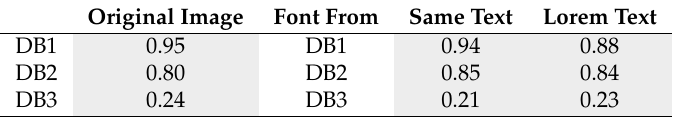
Table 2. Comparison between OCR recognition rates obtained on three different books original images and their synthetic versions. Column 1: OCR recognition rate on original images, Column 2: OCR recognition rate on synthetic images generated with both the text and the font from the original images, Column 3: OCR recognition rate on synthetic images generated with lorem ipsum random text and the font from the original